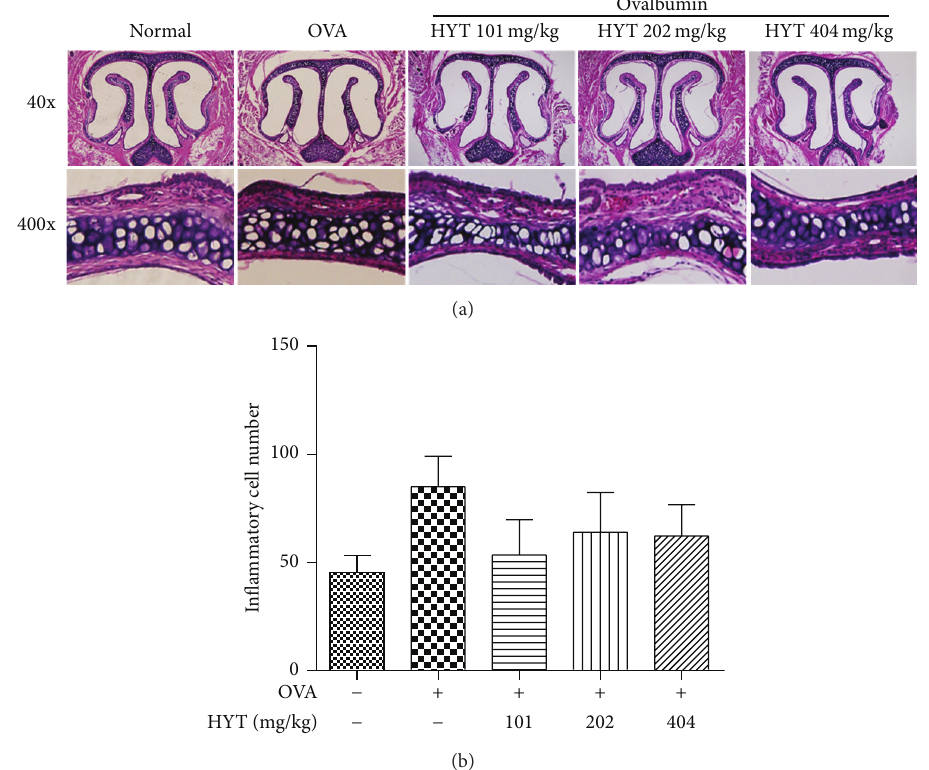
Figure 3: HYT reduced infiltration of inflammatory cells into nasal cavity. The nasal mucosa sections were stained with hematoxylin and eosin. Sections were evaluated using microscope at an original magnification of 40x and 400x. Data are presented as mean ±